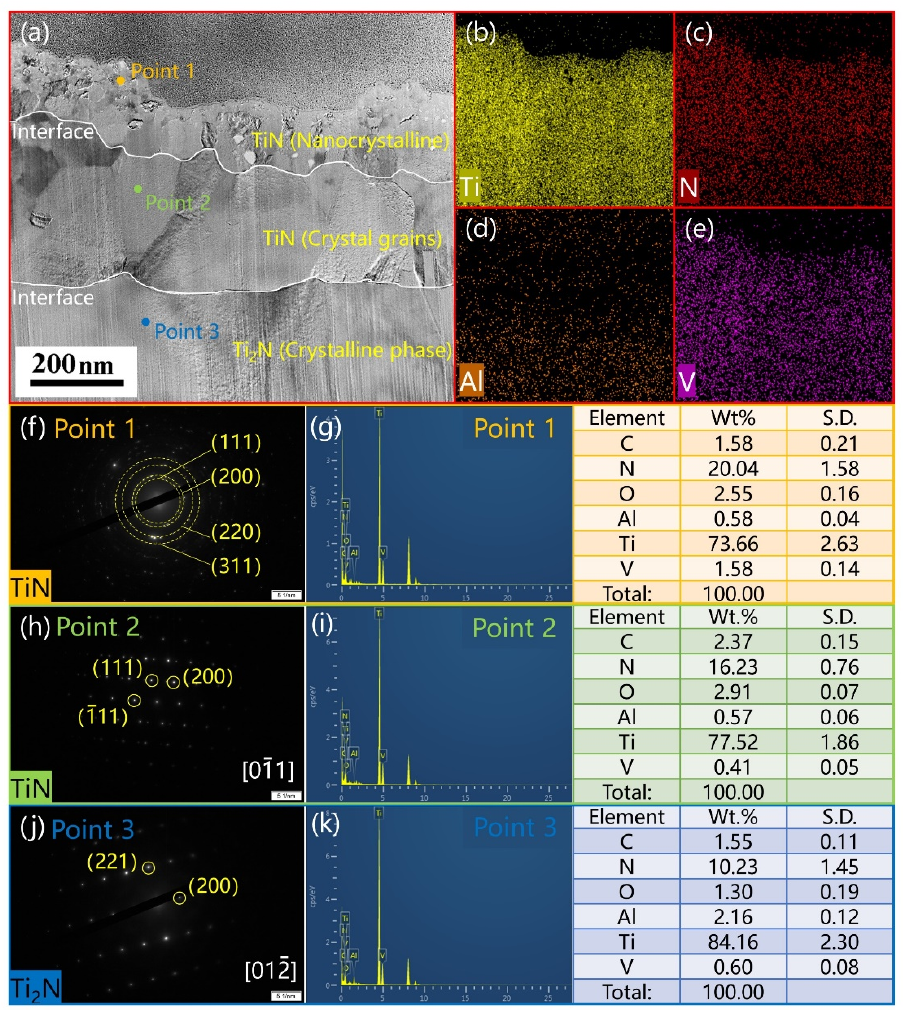
Figure 5. ( a ) Cross-sectional TEM image of sample 510-2. The most superficial layer of the sample is nanocrystalline TiN, and the subsurface layer is the crystalline TiN layer. The lower layer of the TiN layer is the Ti 2 N layer. The interface between the layers is obvious. EDS surface scan was performed for the whole area as shown in ( b ) Ti, ( c ) N, ( d ) Al, ( e ) V. The selected area electron diffraction ( f – j ), and EDS point scan ( g – k ) were performed for Points 1, 2, and 3. The tables show the results of the point scan. The data were averaged over multiple measurements, and the standard deviation